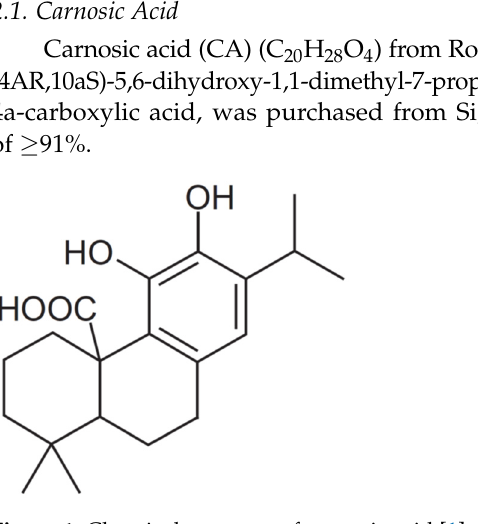
Figure 1. Chemical structure of carnosic acid